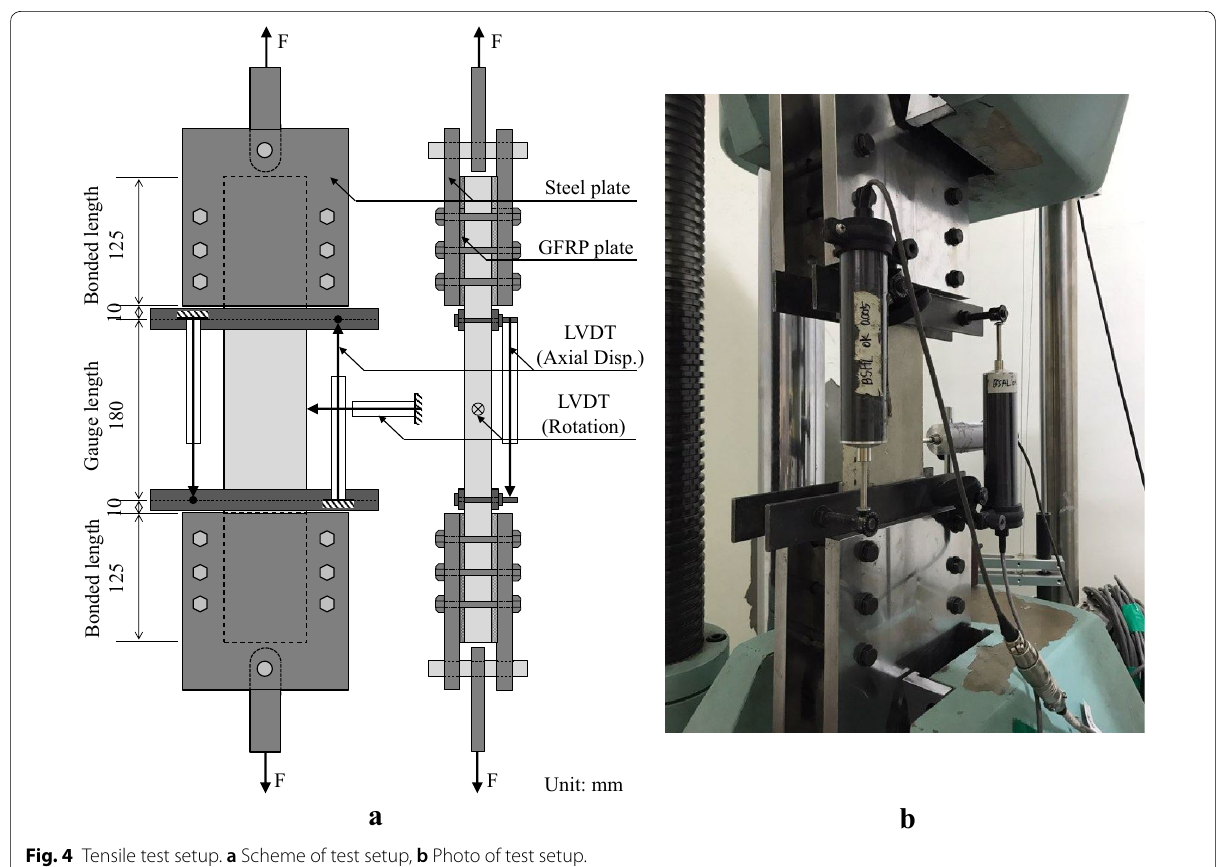
Fig. 4 Tensile test setup. a Scheme of test setup, b Photo of test setup.